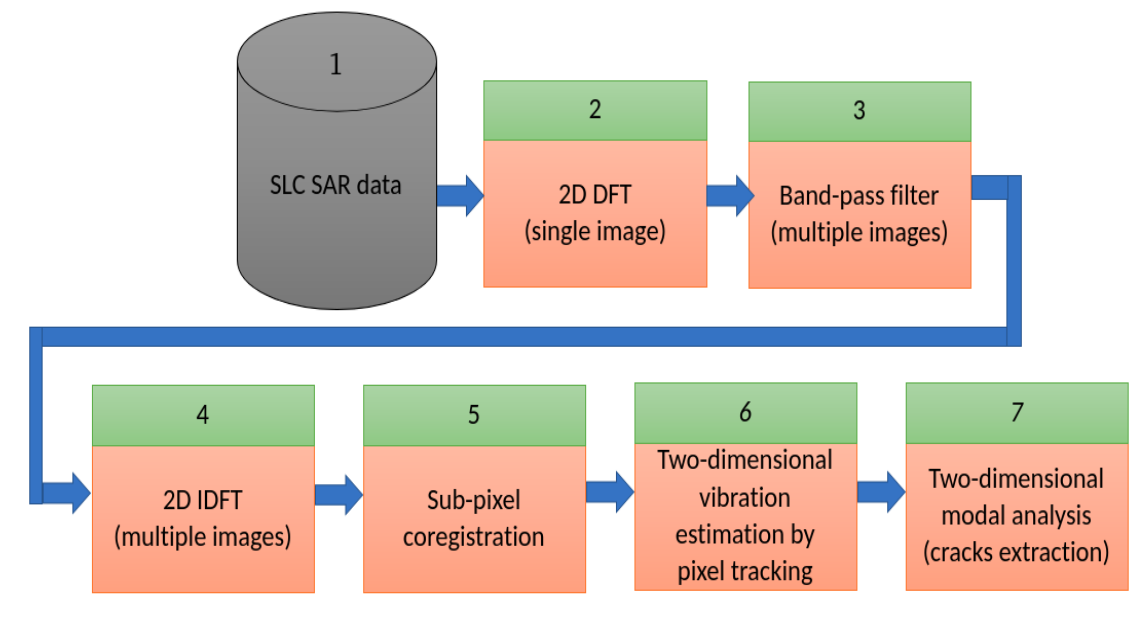
Figure 2. Computational map.